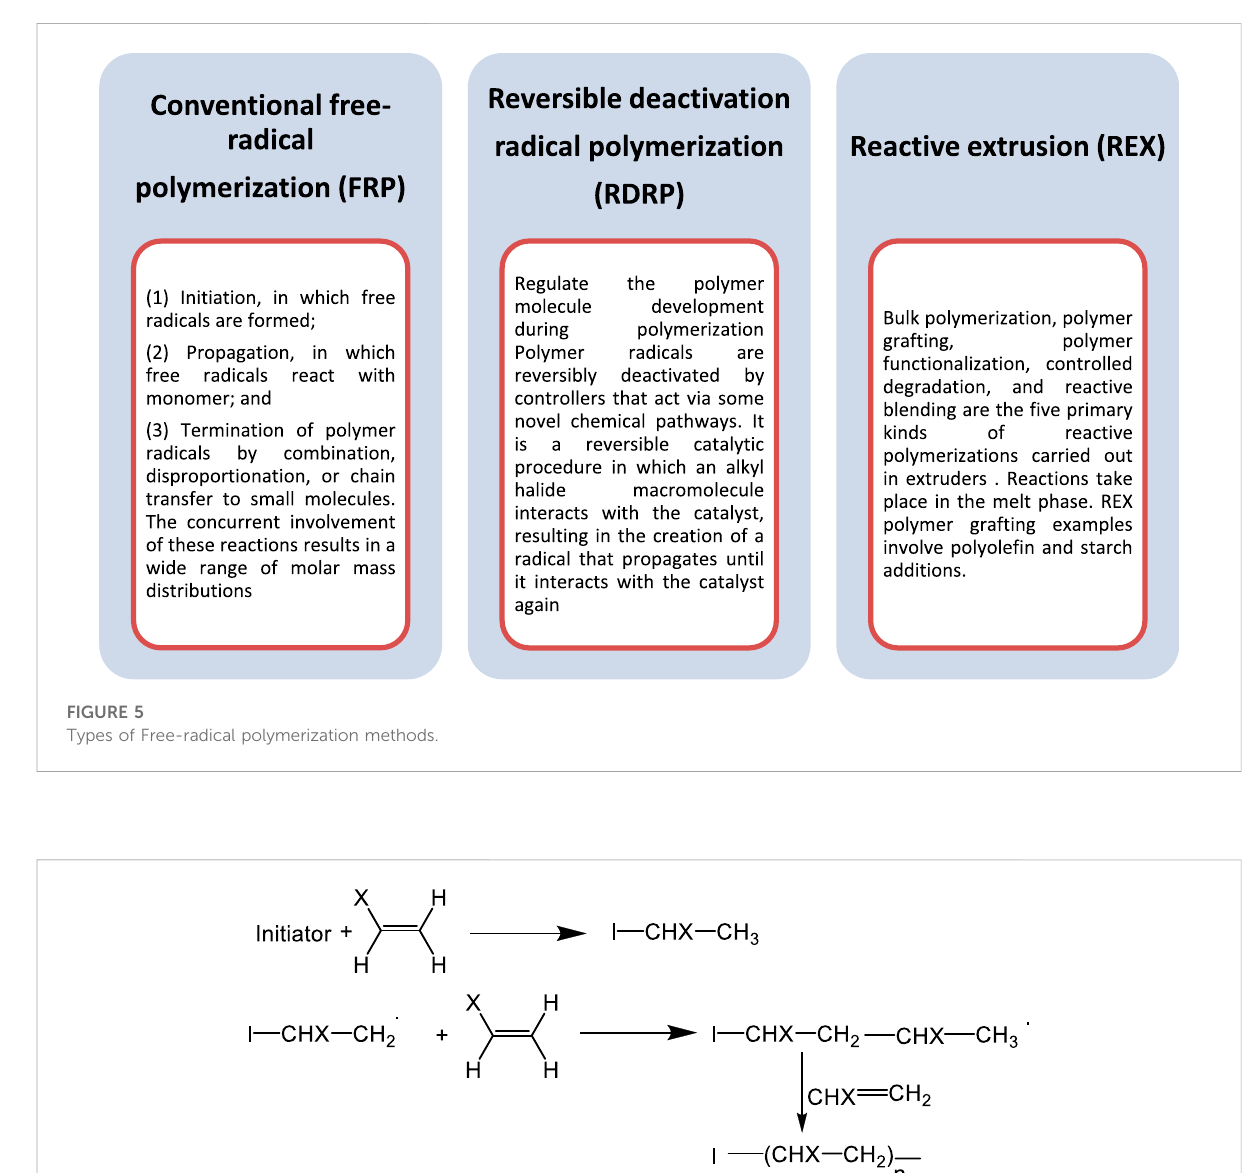
FIGURE 6 Example of free radical